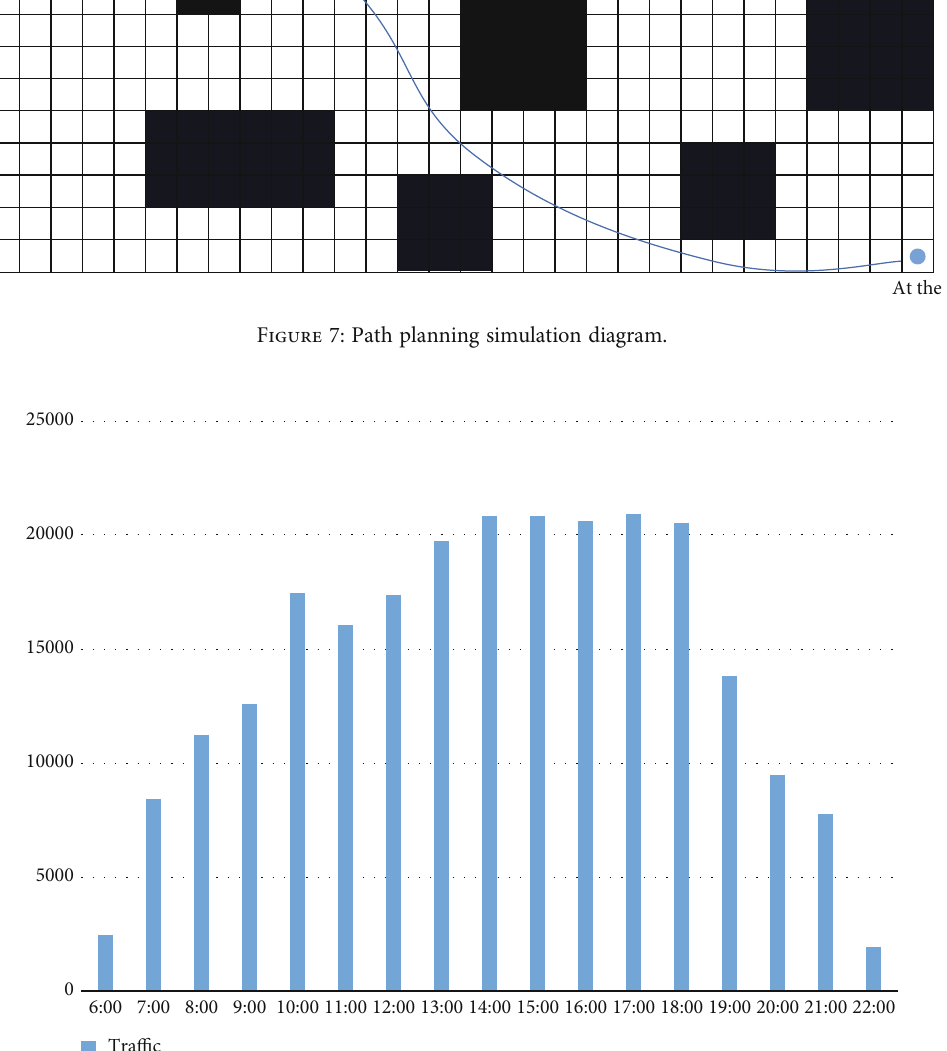
Figure 8: Distribution of incoming passengers at di ff erent time periods on nonworking days.